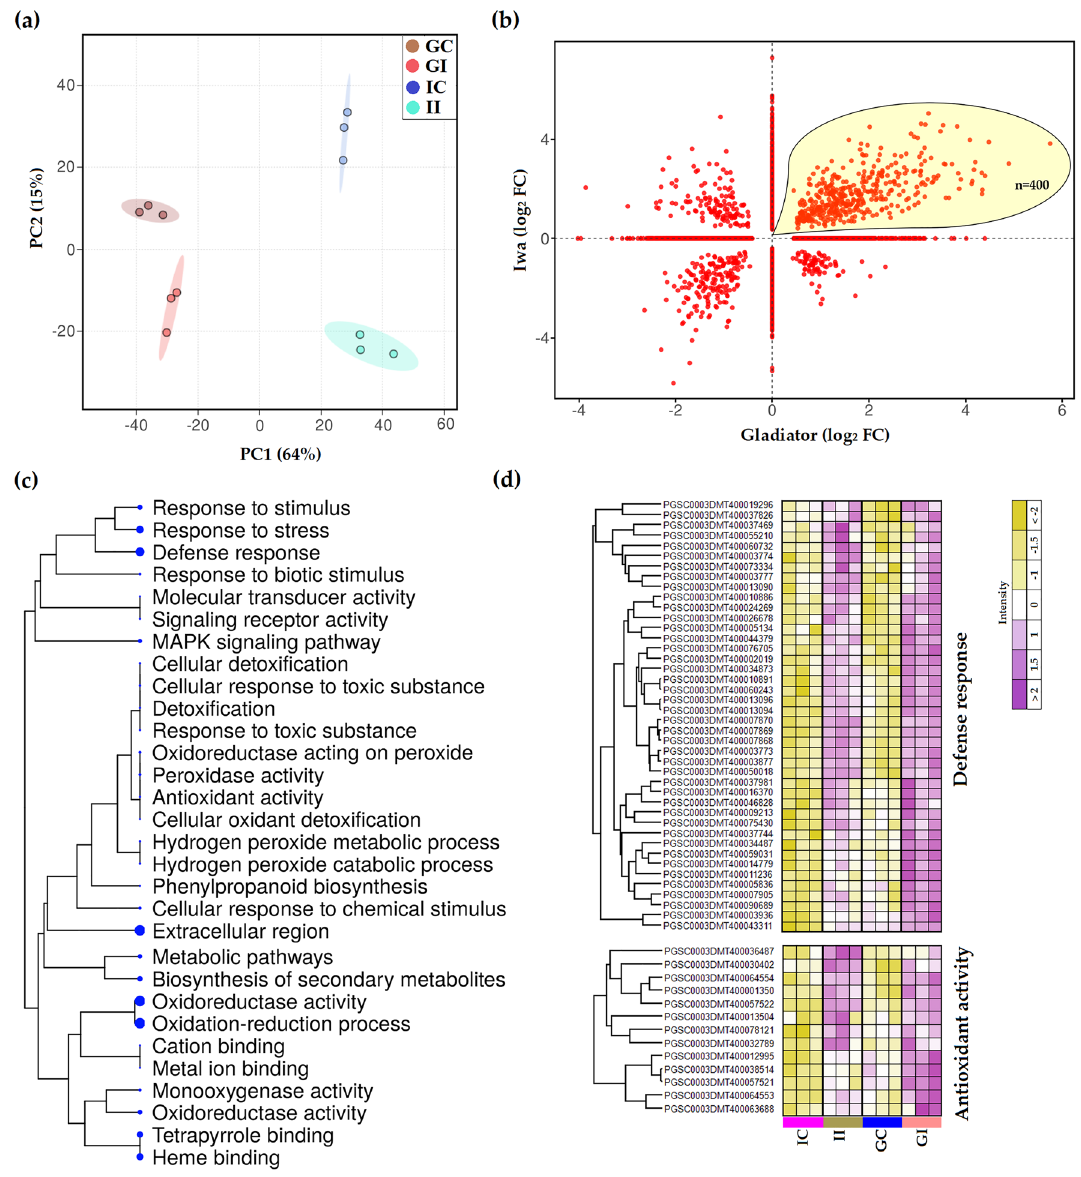
Figure 1. Transcriptional responses of potato to S. subterranea infection. ( a ) Principal component analysis (PCA) differentiates the transcriptomes of control and treated samples from Gladiator (resistant cultivar) and Iwa (susceptible cultivar). ( b ) Distribution of differentially expressed genes (DEGs) common between Gladiator and Iwa. The highlighted area shows that a total of 400 genes were significantly upregulated in both Gladiator and Iwa. The changes in genes were presented as log-transformed fold changes. ( c ) A hierarchical clustering tree summarising the correlation among significant pathways of the upregulated DEGs common between Gladiator and Iwa. Pathways with several shared genes are clustered together. Bigger dots (blue dots) indicate more significant P -values. ( d ) The Z-scored (normalized) expression of defence response and antioxidant activity genes. GI, Gladiator infected; GC, Gladiator control; II, Iwa infected; IC, Iwa